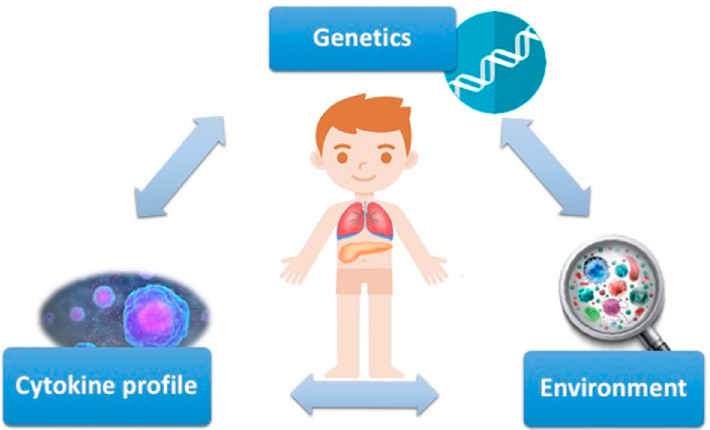
Figure 1. Factors potentially involved in asthma and T1DM development. Children affected by both asthma and T1DM show a unique cytokines profile. This characteristic is probably the result of a complex interaction between genetic polymorphisms and environmental factors. The multifac- torial relationship should be considered as bidirectional in nature, given that every element influ- ences the others without a clear consecutive